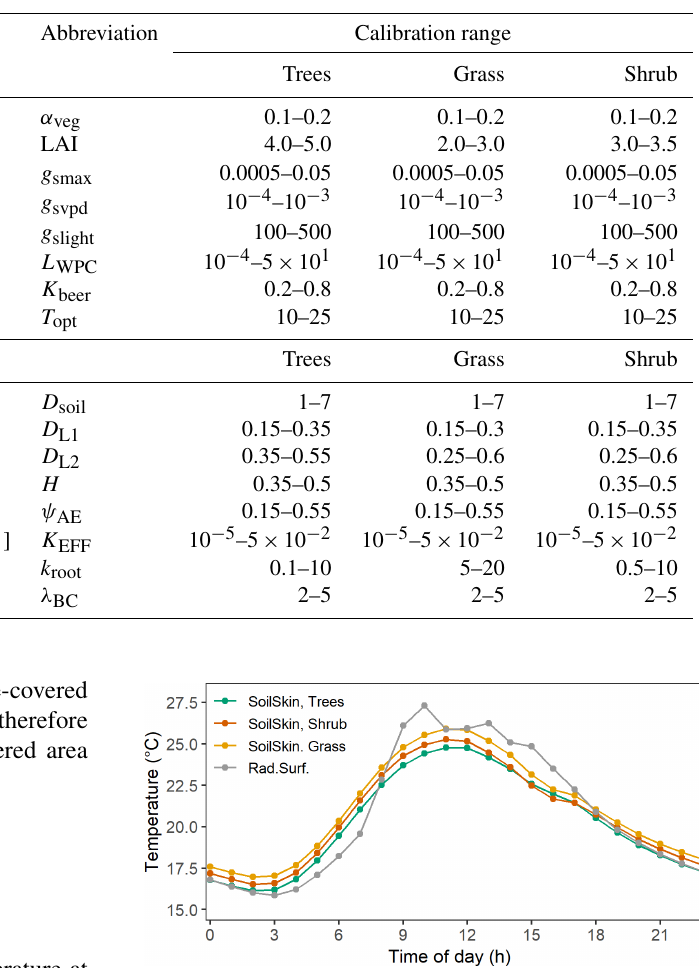
Table 1. Initial parameter ranges of the soil and vegetation parameters used for trees, grass and shrub.